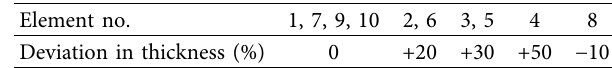
Table 2: Discrepancies between the finite element and the simu- lated experimental